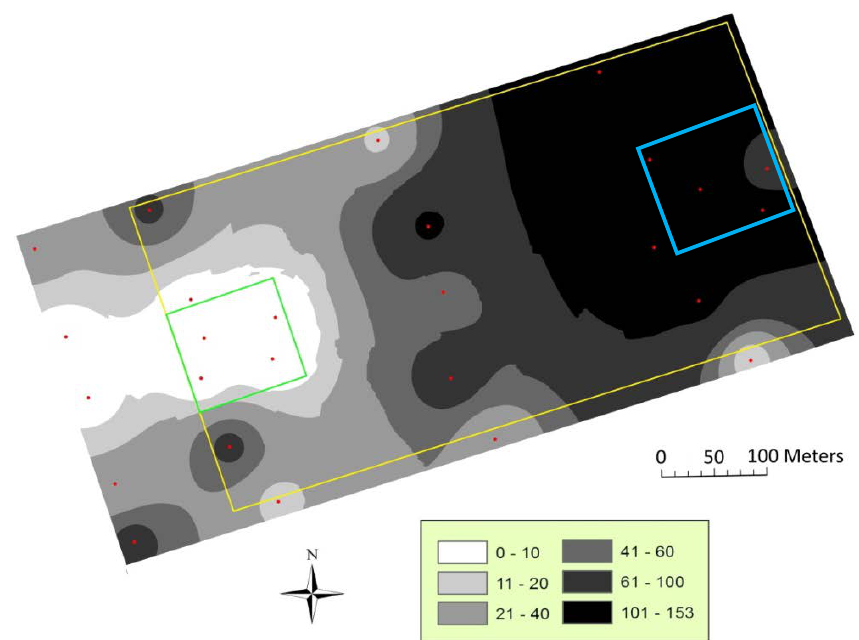
Figure 2. Distribution map of Helicoverpa armigera males in 2011 calculated from the total catch per trap during the sampling period (23 June to 16 August). The mating disruption area (1 ha) is represented by the small square on the left; the control area (1 ha) is represented by the small square on the right. Sampling points (pheromone baited traps) are represented by dots.